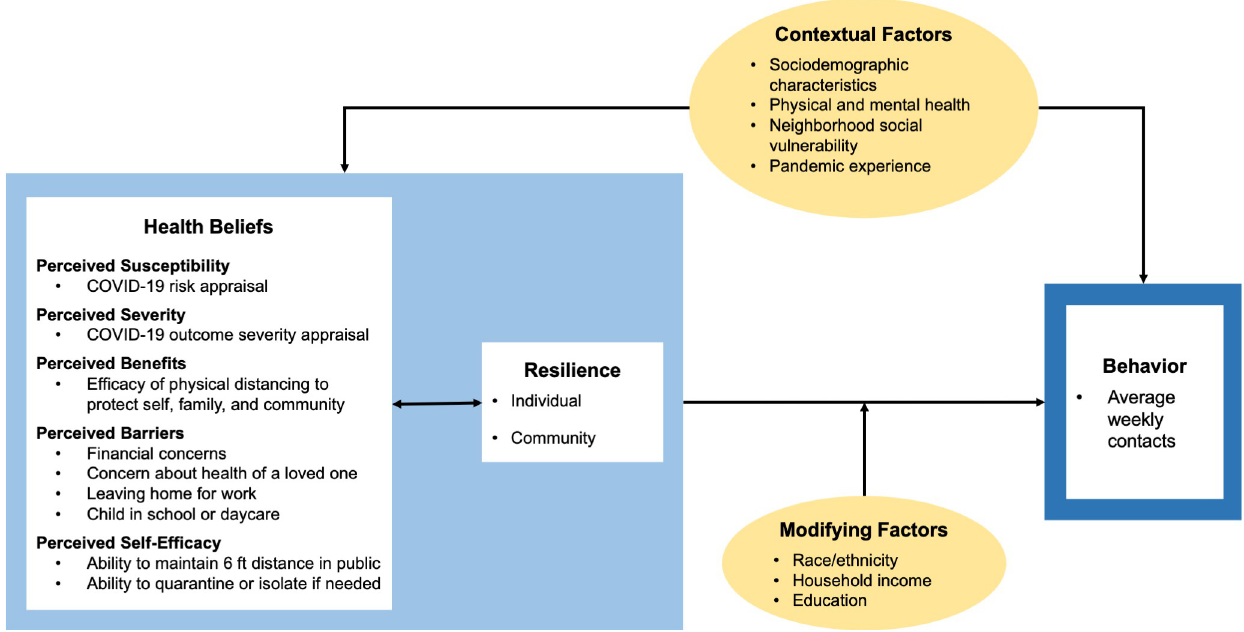
Fig 1. Conceptual model relating cognitive factors from the Health Belief Model and resilience to pandemic non-work, non-household contact rates. The light blue box shows the cognitive factors from the Health Belief Model, ‘Health Beliefs’, and resilience constructs that we evaluated and the variables we used to assess them. Contextual factors were assessed as potentially confounding the association between cognitive factors/resilience and contacts, and modifying factors were considered to modify the association.